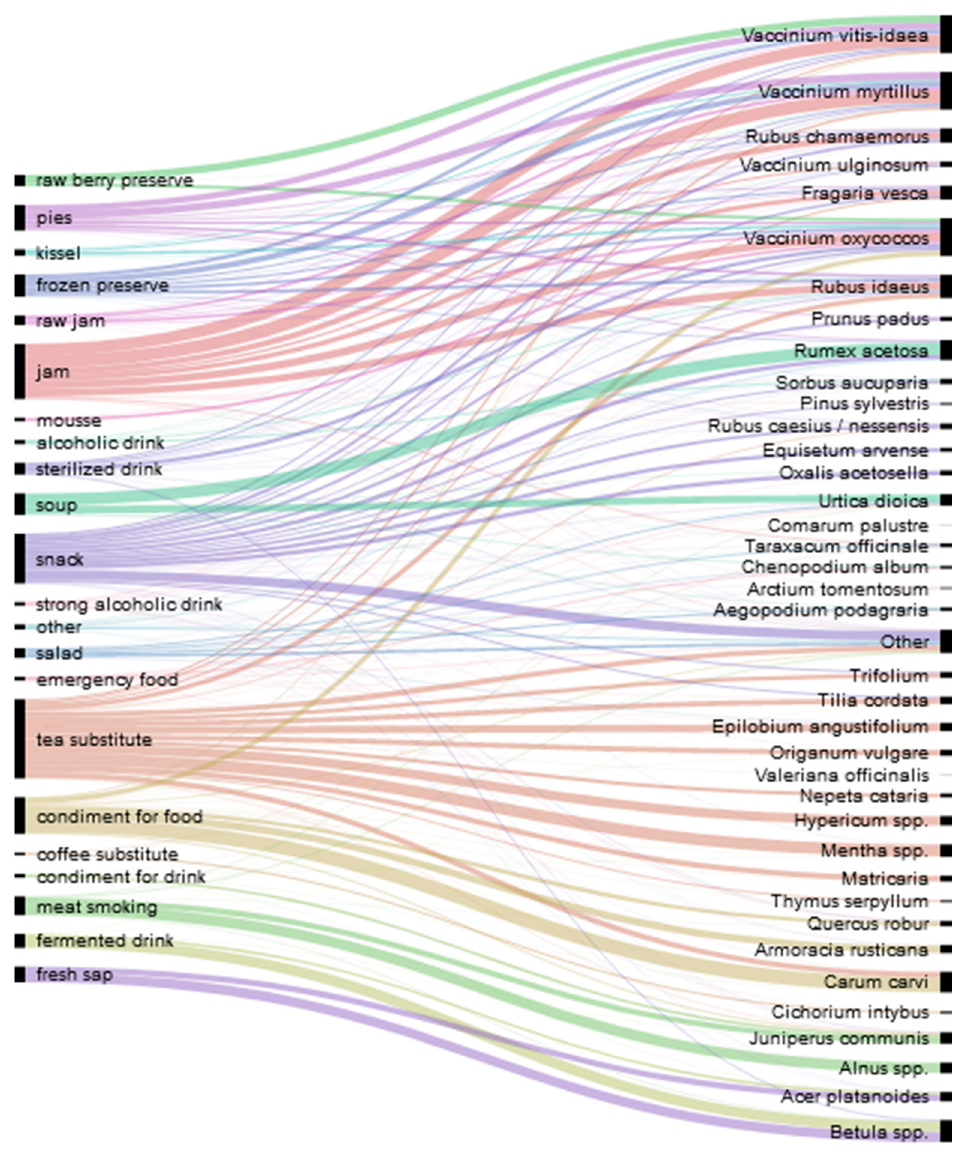
Figure 2. Wild plant taxa used by Setos and Russians as well as dishes made from them. The snacks category mainly represents childhood snacks as we specifically asked about the plants that were consumed or tried during youth but no longer eaten (see also Figure 3). Therefore, this category features all forest berries, acidic plants including Rumex acetosa and Oxalis acetocella , the berries of Prunus padus and the frostbitten berries of Sorbus aucuparia , and the strobilus of Equisetum arvense (Russian ‘pupyshi’). Spring shoots, nee- dles, and the cambium of Pinus sylvestris were mainly reported by Seto participants. A couple of Russian participants mentioned eating the white sugary stalk bottoms of Schoe- noplectus lacustris (L.) Palla (Russian ‘trosta, kamysh’). A general preference for sugary snacks was characteristic of those who grew up during wartime or shortly thereafter. “ Well, it’s like […] a little stem, the size of a finger. There’s a little cone, one did not eat it. And this stem, it was sweet. I don’t know why but we sucked it. We